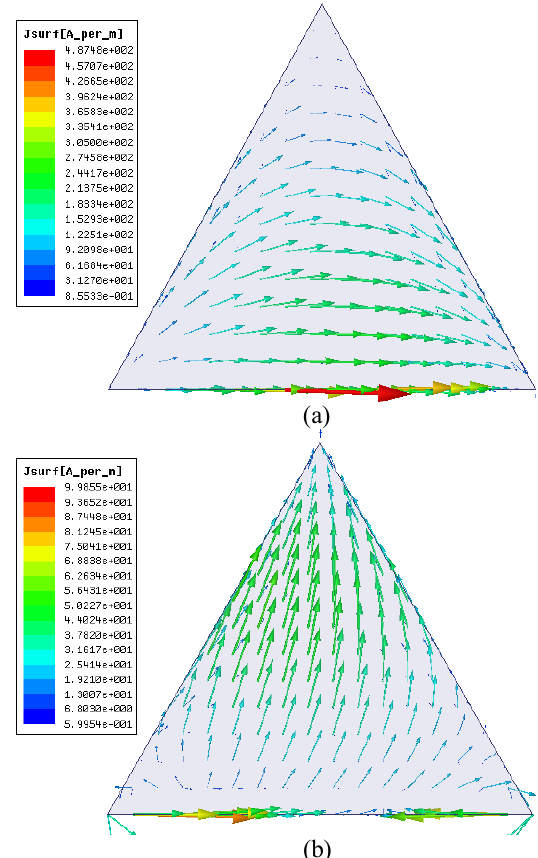
Figure 2: Surface current distribution of triangular patch (a) odd mode, (b) even